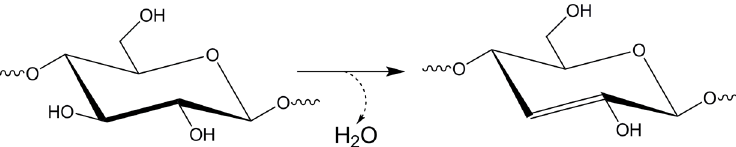
Figure 8. The reaction of cellulose dehydration.